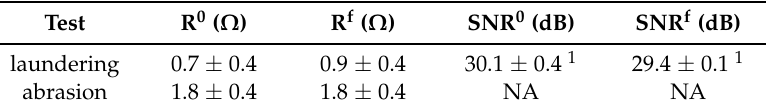
Table 5. Wear resistance